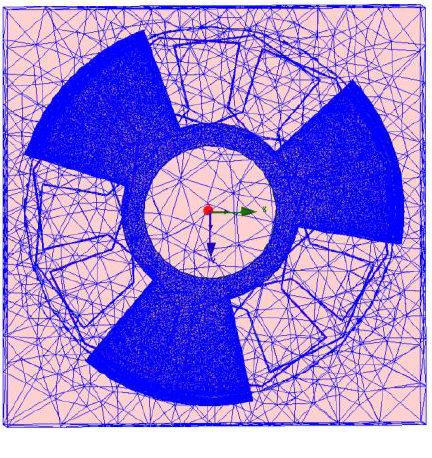
Figure 4. 3D modeling of studied sensor under mesh operation.